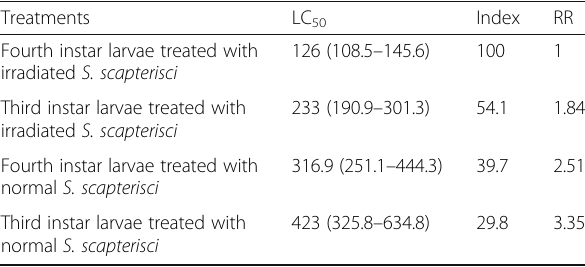
Table 3 LC 50 after 48 h treatment with non-irradiated